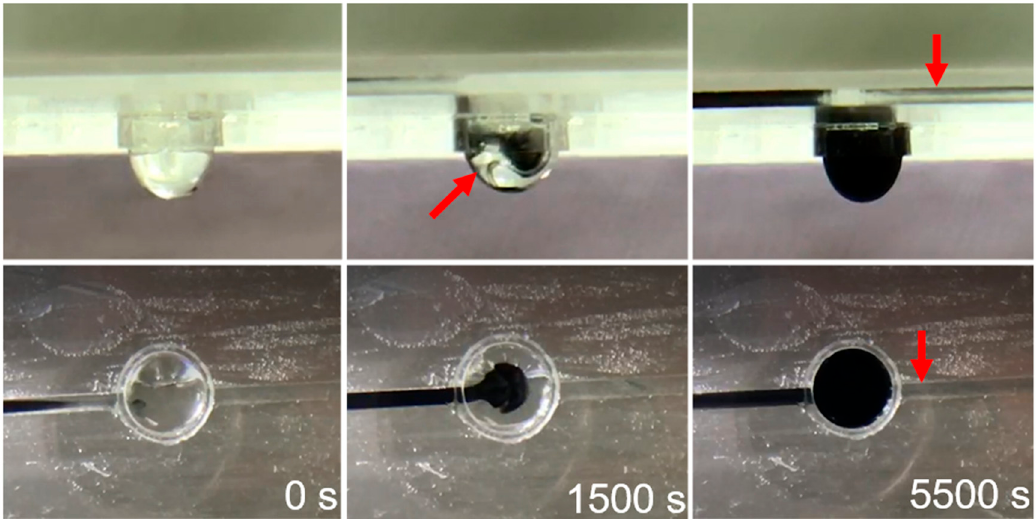
Figure 3. Schematic diagram of medium exchange, side view, and top view: at 0 s, the droplet is colorless. To 1500 s, new medium (black) infusion, we can see the liquid agitated and merged gradually. Until 5500 s, the droplet color changed into black and some medium toward the outlet.